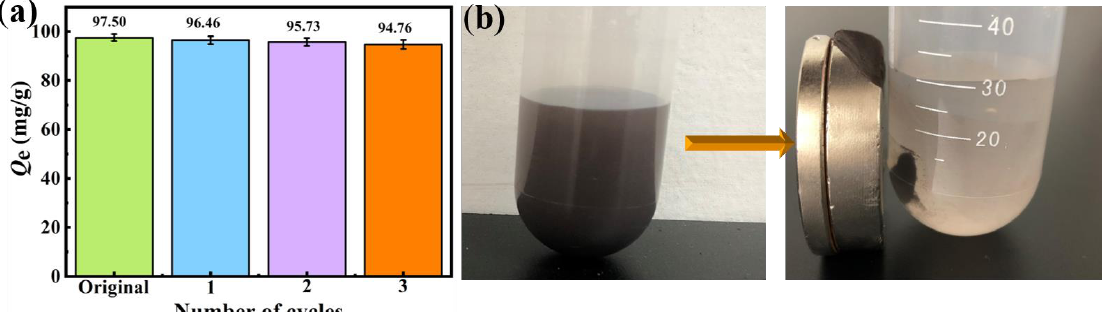
Figure 11. Reusability of LMF11 NFs ( a ) and photo of magnetic separation ( b ).